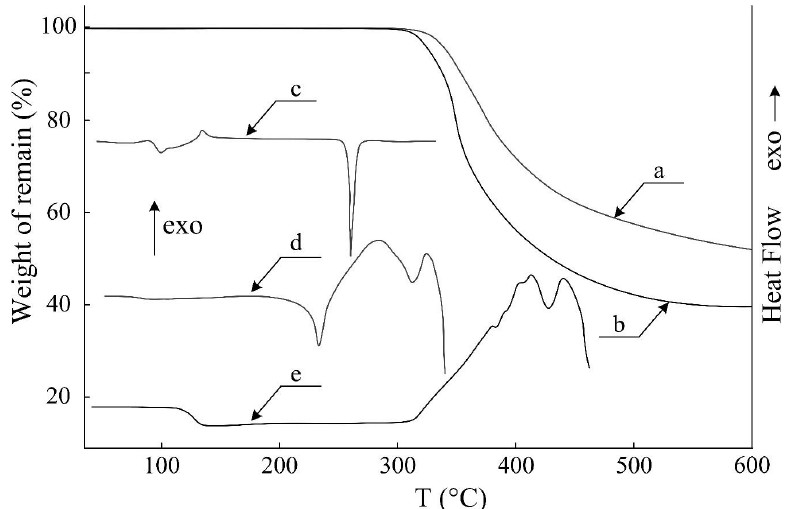
Figure 2. TGA curves for ( a ) cured composition and ( b ) mixture of ACP and DER-331; and differential scanning calorimetry (DSC) curves for ( c ) ACP, ( d ) mixture of ACP and DER-331, and ( e ) cured composition. Polymers 2019 , 11 , x FOR PEER REVIEW